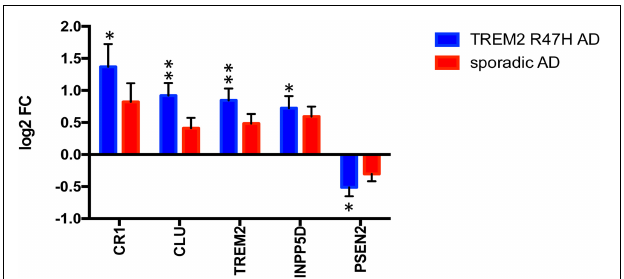
FIGURE 2 | Perturbed expression of AD genes/risk factors in TREM2 R47H AD. AD-associated genes altered (FDR < 0.1) in at least one condition against a baseline of gene expression in controls are shown. Data are presented as mean ± SD ( ∗ adj p -value < 0.05; ∗∗ adj p -value < 0.01); y -axis displays log2 (FC, fold changes) value.